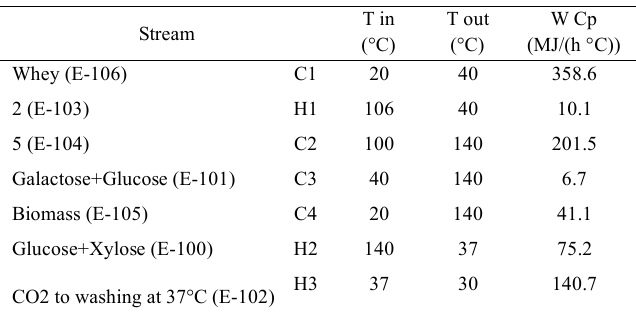
Table 2. Temperatures of streams possible to take part in